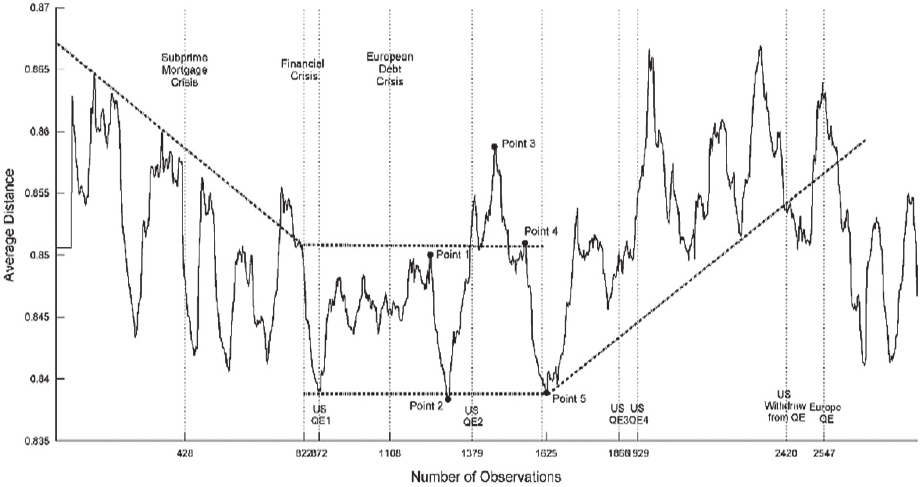
Fig. 5. Average distance of global stock